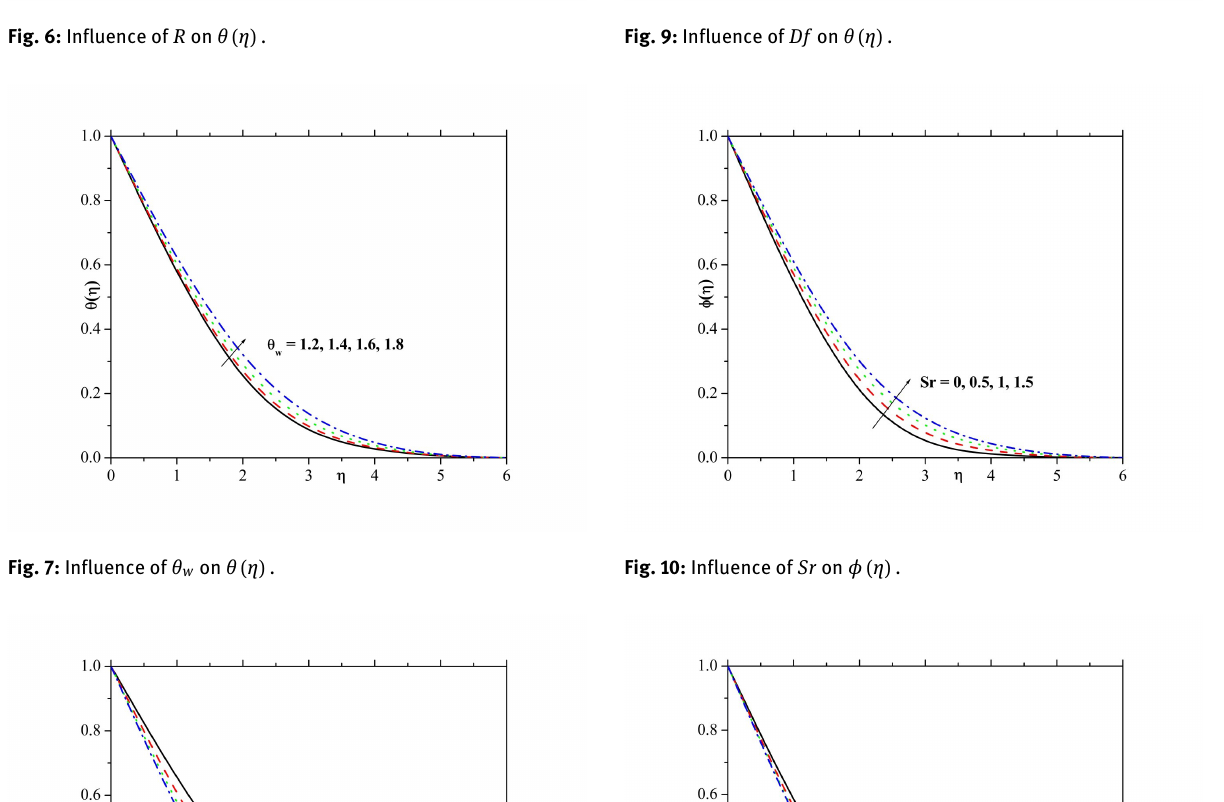
Fig. 9: Influence of Df on θ ( η ) .